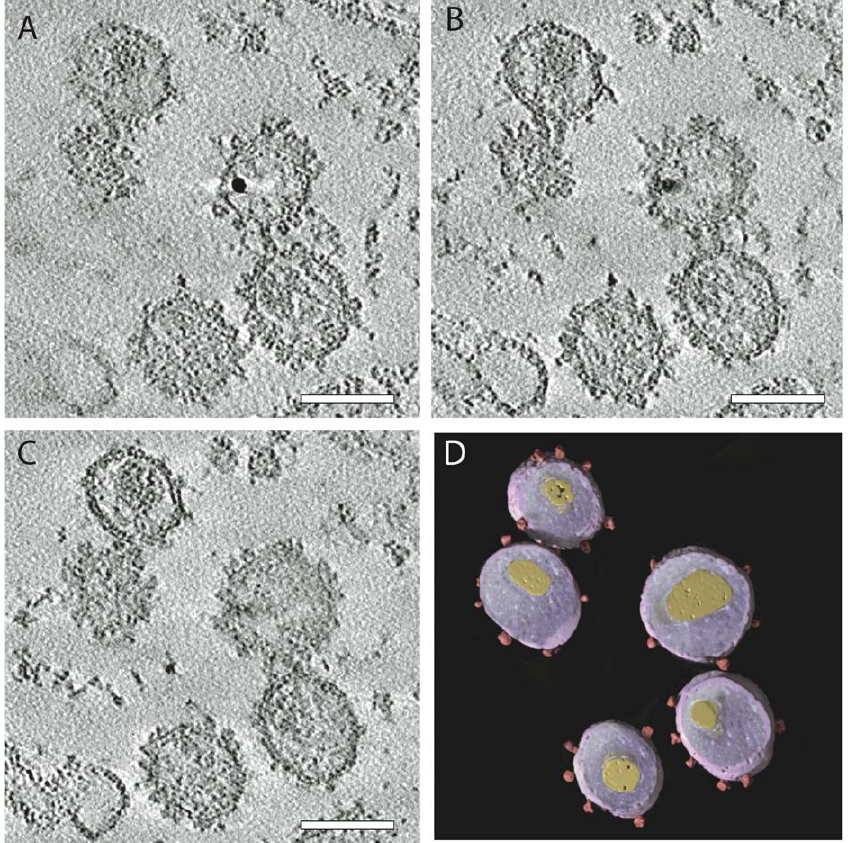
Figure 3. Structural Analysis of Virions from an SIV-Infected T Cell Preparation (A–C) Three 1-nm slices at different depths from a tomogram of a 150-nm-thick section of fixed, plastic-embedded T cell shows virions in the extracellular space. (D) 3-D surface rendering of the virions shown in (A–C). The size and appearance of these viruses imaged in fixed, plastic-embedded cells at room temperature is closely comparable to those observed in vitrified specimens of purified viruses analyzed by low-dose electron tomography at liquid nitrogen temperatures. Scale bars are 100 nm long in all panels.